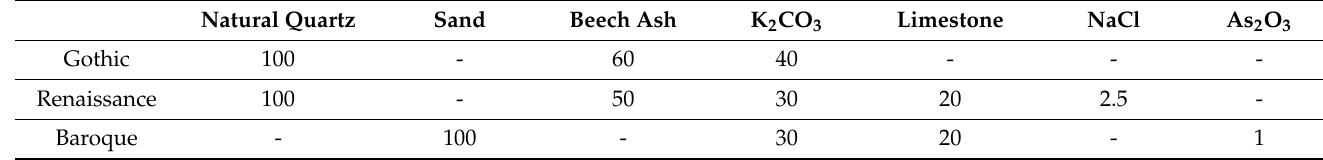
Table 1. Weight ratios of raw materials used to mix model glass batches [g]. Natural Quartz Sand Beech Ash K 2 CO 3 Limestone NaCl As 2 O 3